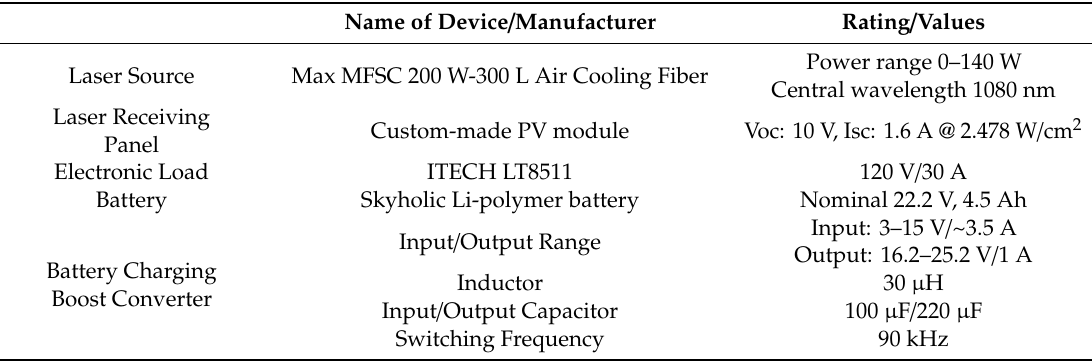
Table 2. Experimental setup of the laser charging system.